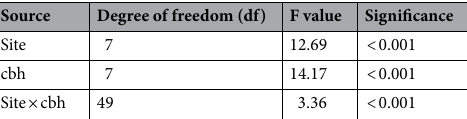
Table 3. Two-way ANOVA for effects of sites and cbh classes on flower yield and their interaction.